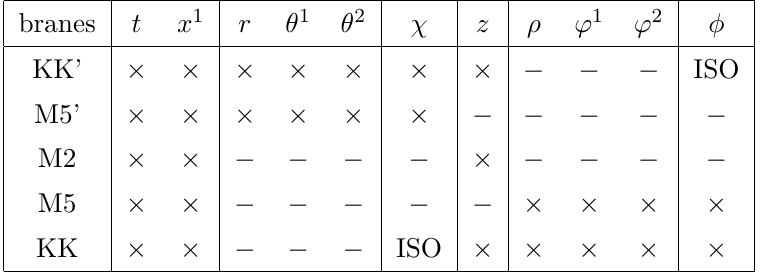
Table 1 . BPS/8 brane system underlying the intersection of M2-M5 branes ending on M5’-branes with KK monopoles. χ ( φ ) is the Taub-NUT direction of the KK (KK’)